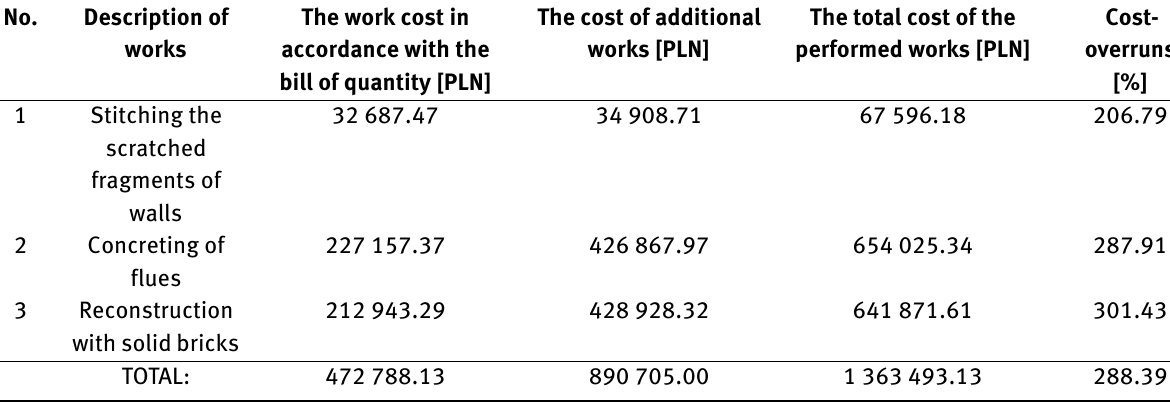
Table 2: Cost list of selected renovation works from a bill of quantities and a quantity survey No.